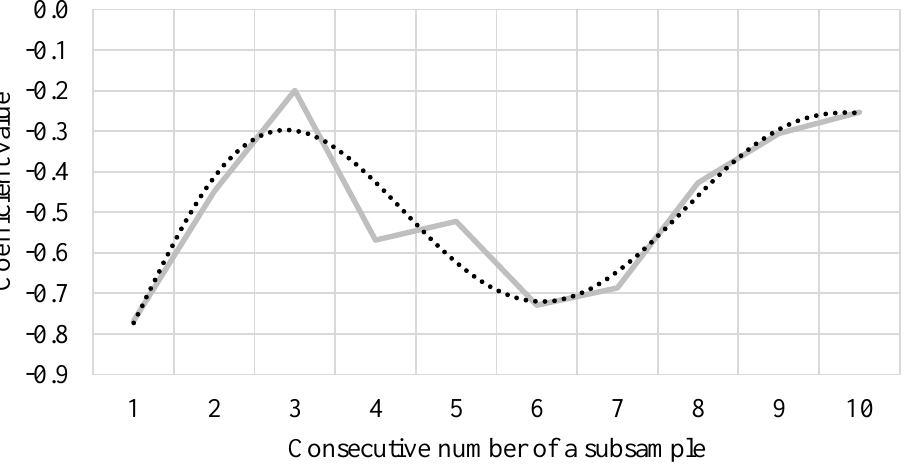
Figure 1. Coefficient value dynamics for closed credit sum.